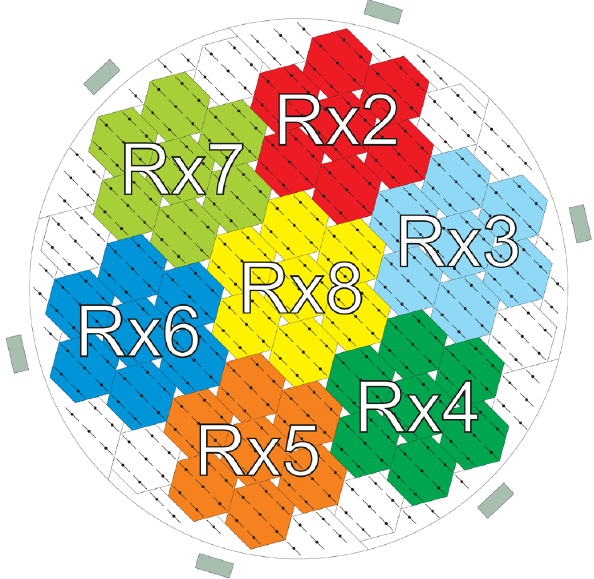
Fig. 1. MAARSY receiver constellation during the ECOMA cam-